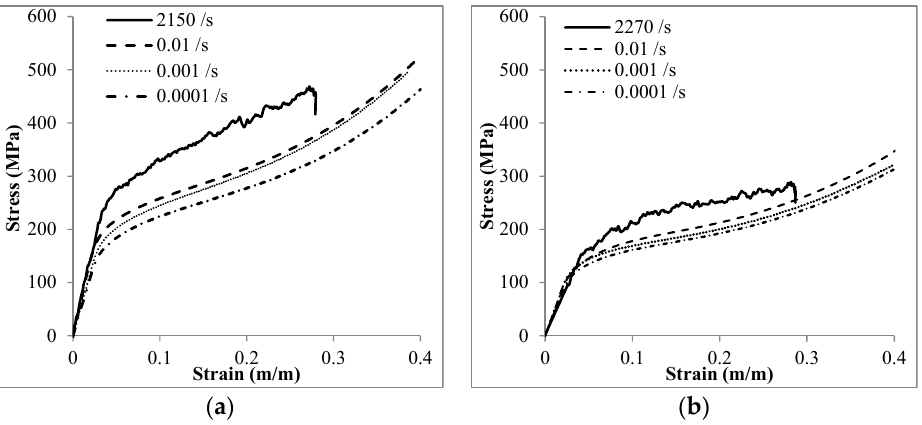
Figure 6. The compressive response of ( a ) Invar ‐ 5CS; and ( b ) Invar ‐ 10CS at high strain rate loading in comparison to the quasi ‐ static loading.